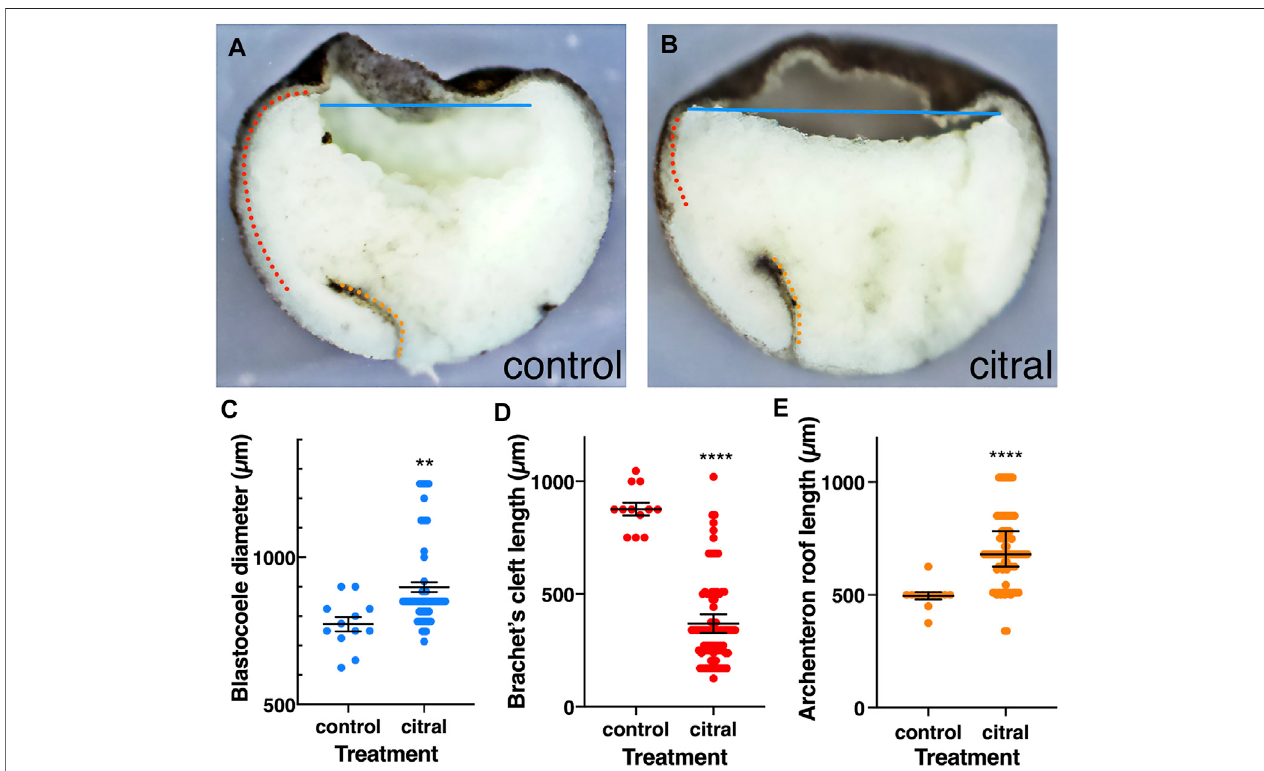
FIGURE 6 | Internal reorganization of the embryo as a result of reduced RA signaling. Control (n = 12) and citral-treated (n = 84) embryos were incubated to mid- gastrula (st. 11) and bisected sagittally. (A,B) Control and citral-treated bisected embryos. Blastocoele diameter, blue line; Brachet ’ s cleft; dotted red line; Archenteron roof, dotted orange line. (C) Distribution of the blastocoel diameter in control and citral-treated embryos. (D) Measurement of Brachet ’ s cleft length in citral-treated and controlembryos. (E) Lengthofthearchenteronroofincitral-treatedandcontrolembryos.Citral-treatedembryoswerecomparedtothecontrolvalues.**, p < 0.01; ****, p <